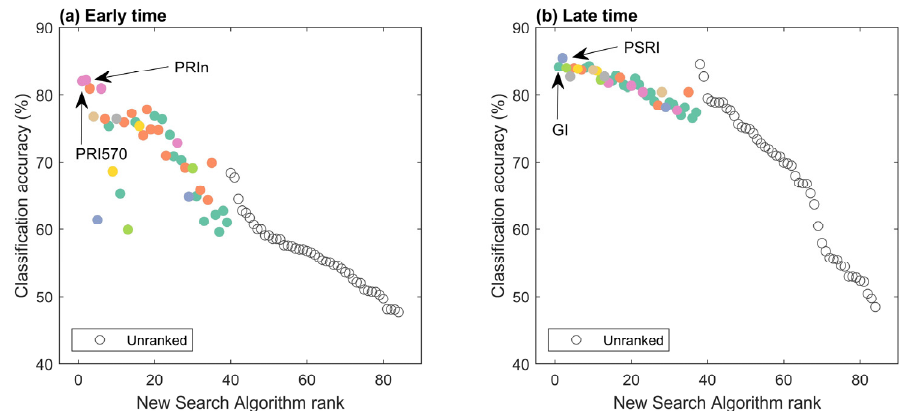
Figure 9. Early time and late time assessment of ranked search algorithm. ( a ) “Early time” was averaged over the first four acquisition dates when the number of infected seedlings with symptoms <32%. ( b ) “Late time” was averaged over the last four acquisition dates when the number of infected seedlings with symptoms >72%. Noteworthy indices with the highest classification accuracy are indicated with arrows and labels. Colors were used for VI groupings and are the same as in Figure 7.